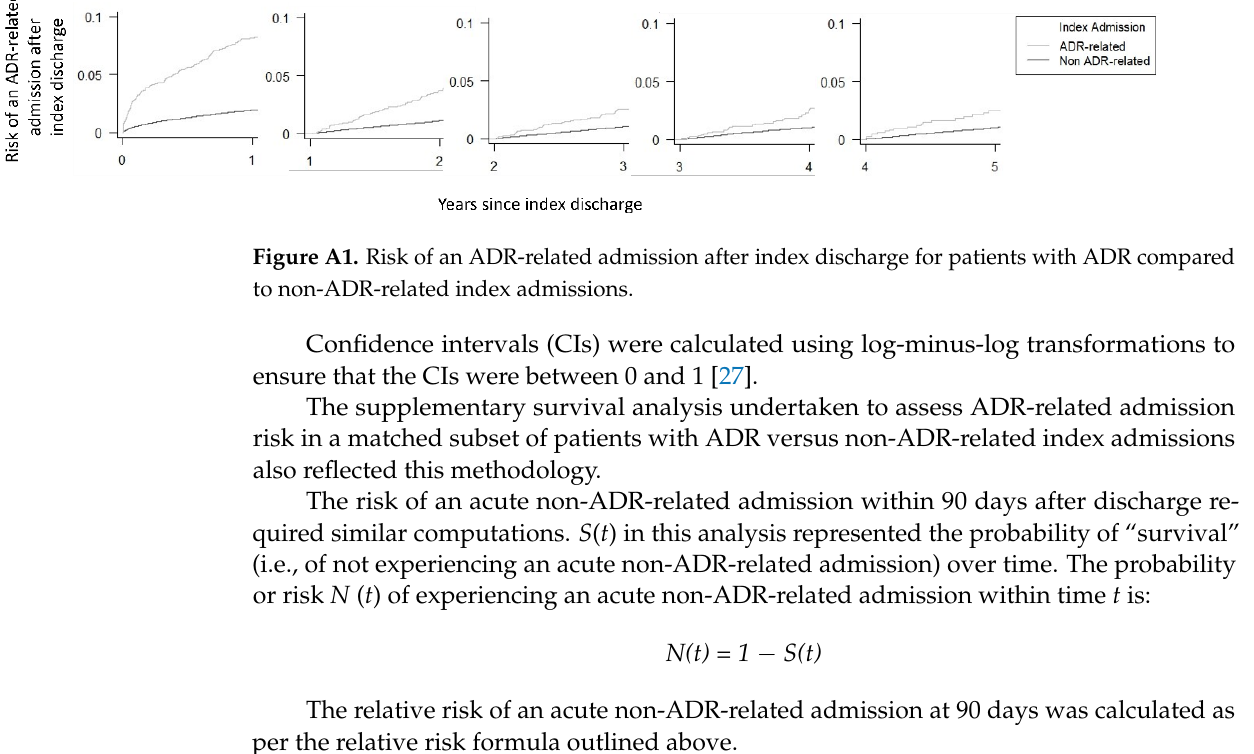
Figure 1. Note that the survival curve for the first year of follow-up is a reconstruction of Figure 1 from the main text, with the x-axis restricted to 0–1 years.